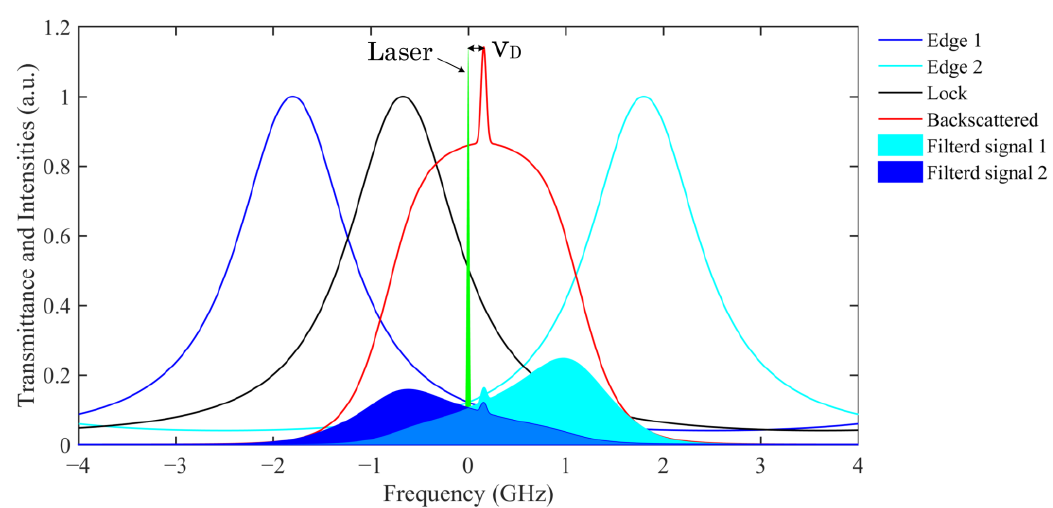
Figure 1. Principle of frequency discrimination of FPI.